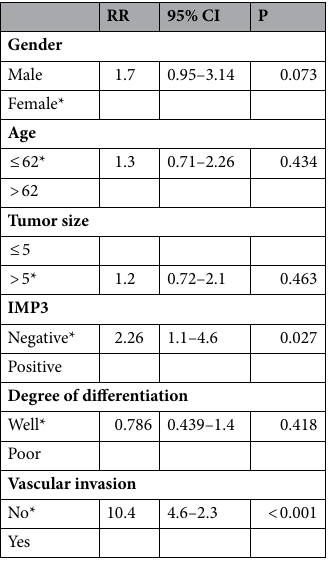
Table 6. Results of Cox’s regression multinomial analysis for overall survival of CRC clinical stage II. *Reference